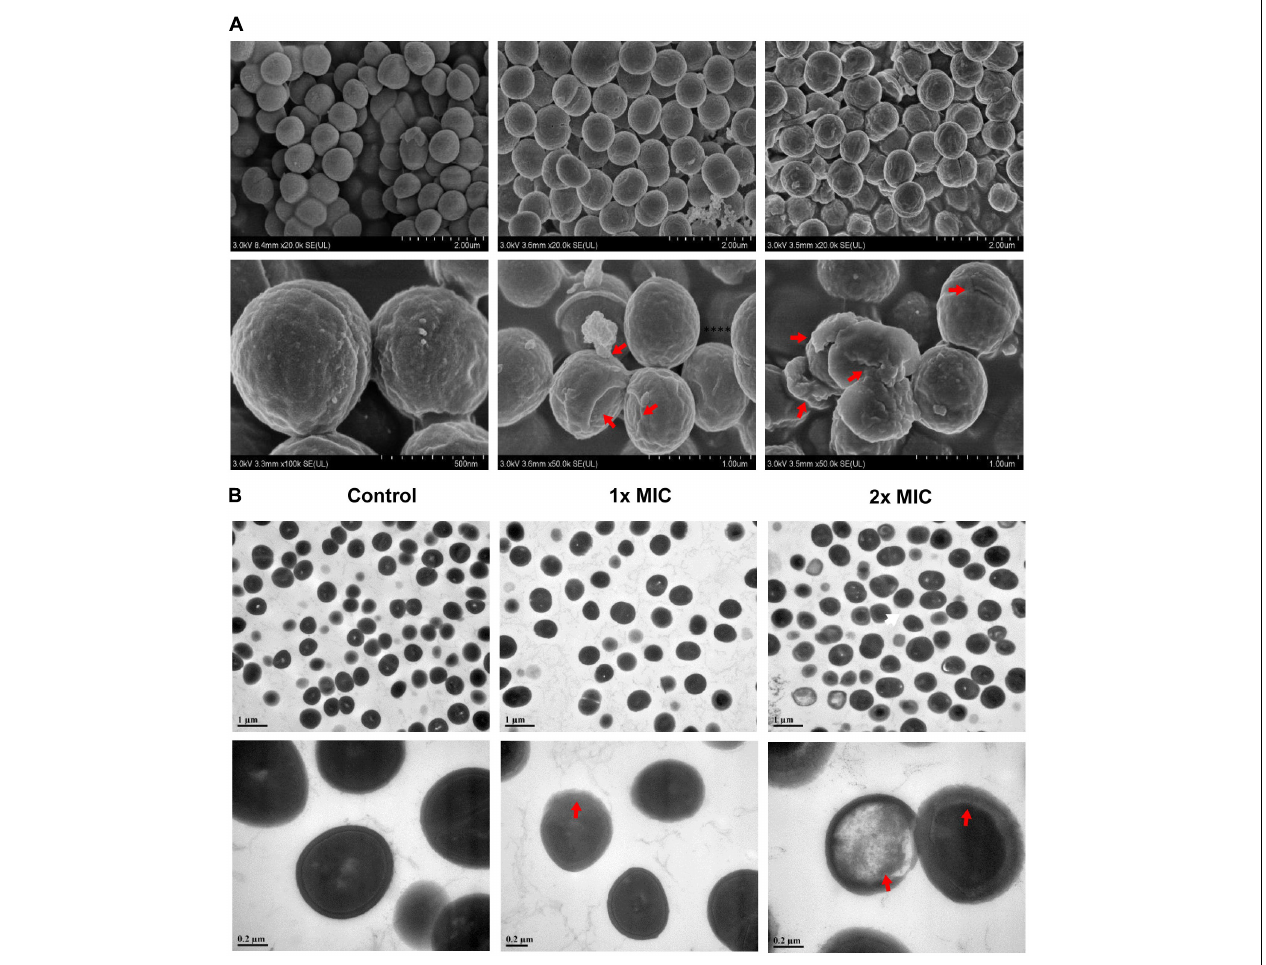
FIGURE 2 | MCA altered the morphology and ultrastructure of MRSE. After treatment with MCA of indicated concentrations for 6 h, the bacteria were collected, fixed, and prepared for electron microscopy analysis. The images from SEM and TEM are shown in panels (A,B) , respectively. The scale bar in panel (B) indicate 1 and 0.2 µ m in the upper and lower panels, respectively. The indications of cell membrane damage, corrugation, shriveling, and the leakage of the cytoplasm are highlighted with red